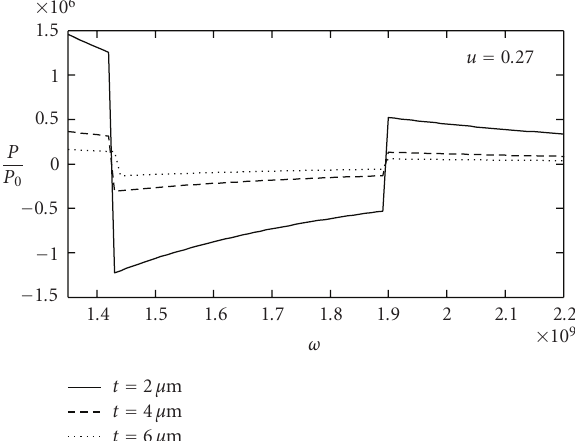
Figure 2: The e ff ective nonlinear refractive index versus the angular frequency at nonlinearity u = 0 . 27, for di ff erent dielectric slab thicknesses.